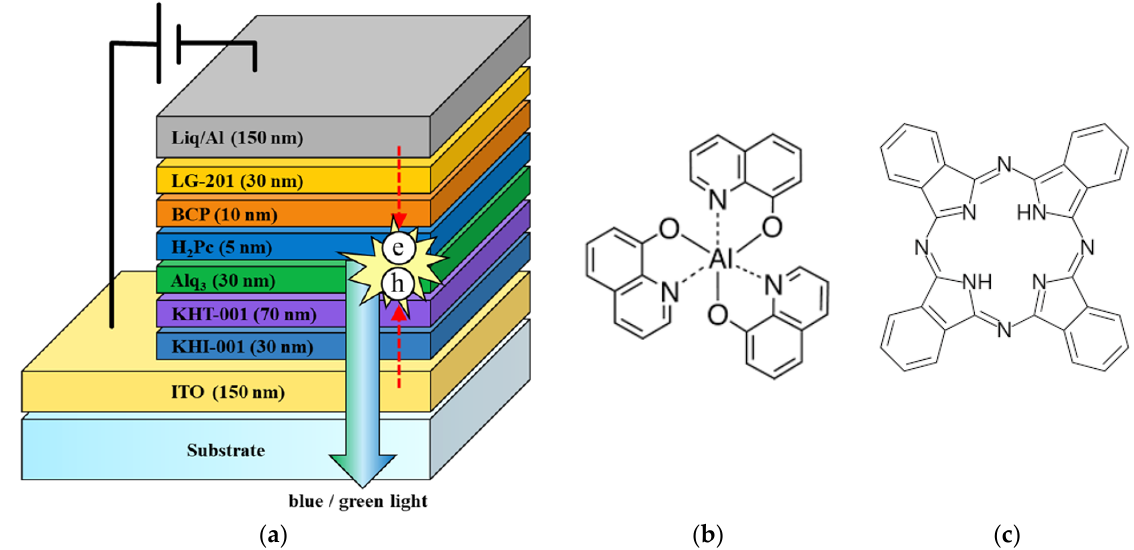
Figure 1. ( a ) Schematic of proposed single-cell color tunable organic light-emitting diode (CTOLED) and chemical structures of ( b ) tris (8-hydroxyquinoline) aluminum (III) (Alq 3 ) and ( c ) phthalocyanine (H 2 Pc).